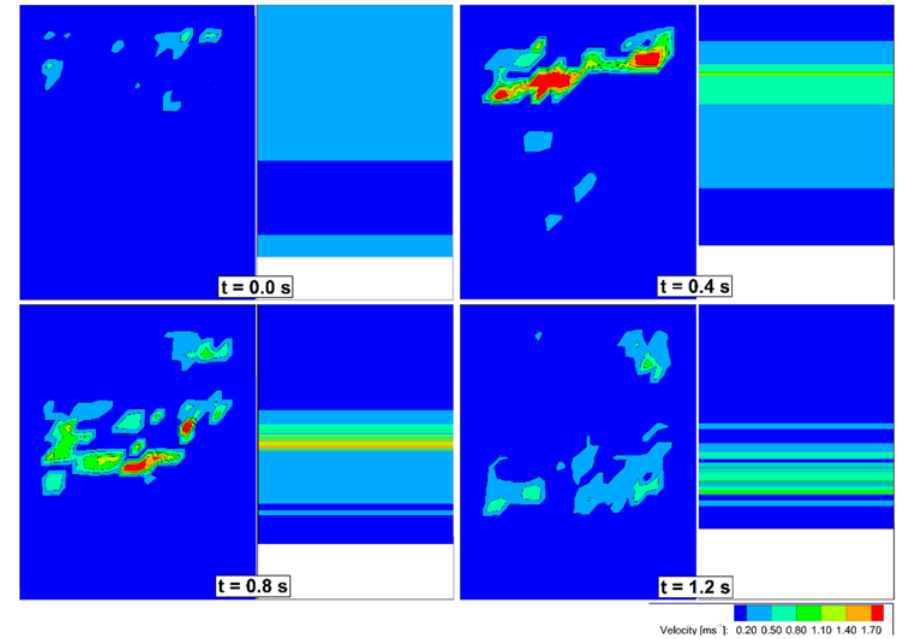
Figure 17. Comparison of surface velocities calculated with LSPIV ( left ) and CFD ( right ); dt = 0.4 s.